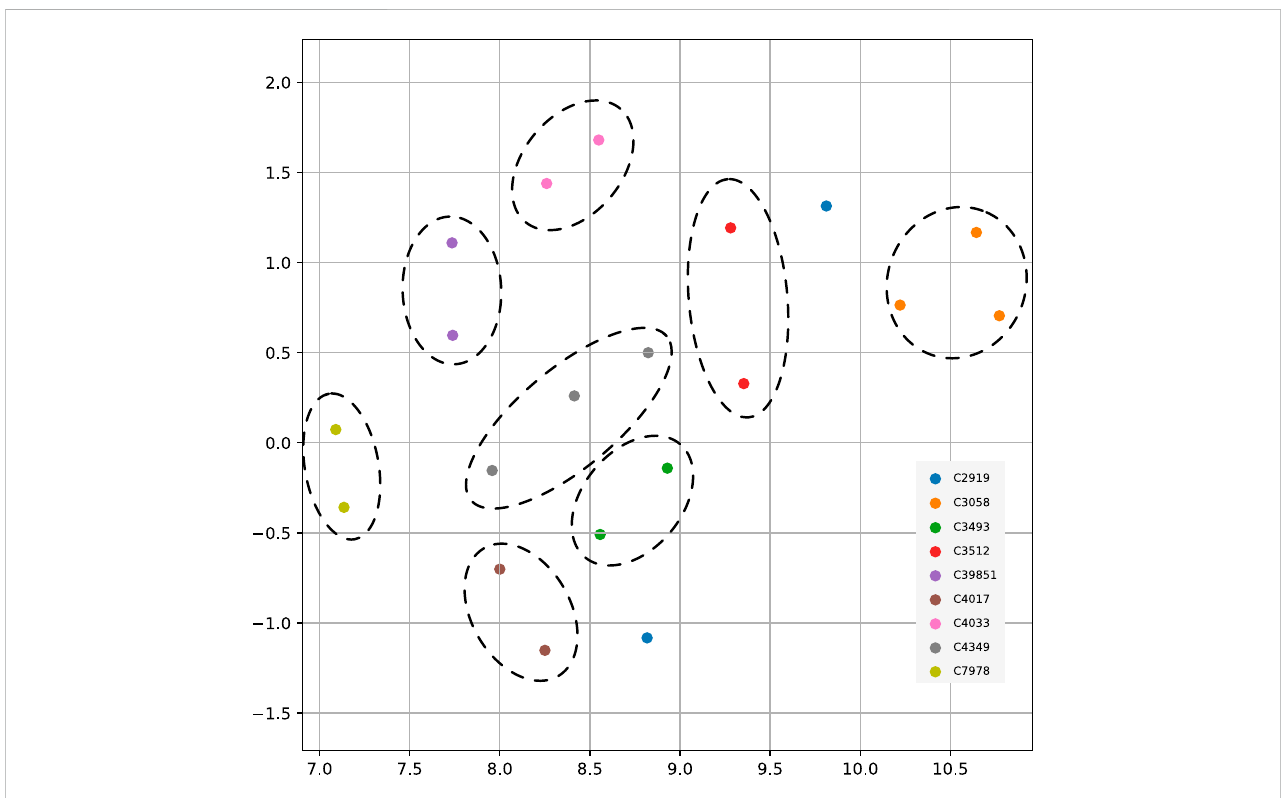
FIGURE 5 UMAP projection of genome-wide signi fi cance scores among nine paired cancer types from multiple data sources. In order of appearance the NCIt codes in the fi gure legend represent - C2919: Prostate Adenocarcinoma; C3058: Glioblastoma; C3493: Lung Squamous Cell Carcinoma; C3512: Lung Adenocarcinoma; C39851: Bladder Urothelial Carcinoma; C4017: Ductal Breast Carcinoma; C4033: Clear Cell Renal Cell Carcinoma; C4349: Colon Adenocarcinoma; C7978: Ovarian Serous